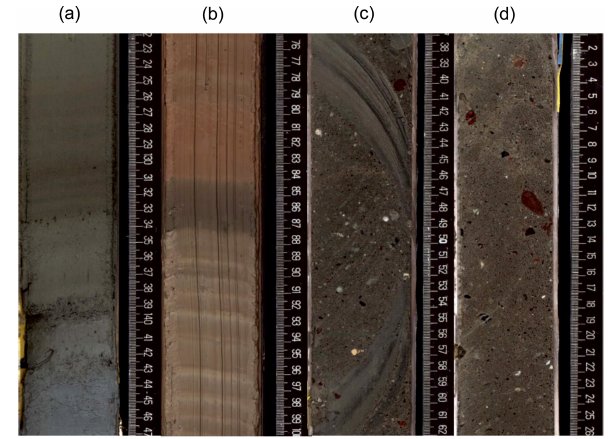
Figure 6. Hanö Bay, site M0064. Examples of varved glacial clay ( a and b ) and diamicton (c, d) . The greyish brown unit between 84 and 87cm separating the two different types of varved glacial clays in section b have an age of 45700 ±